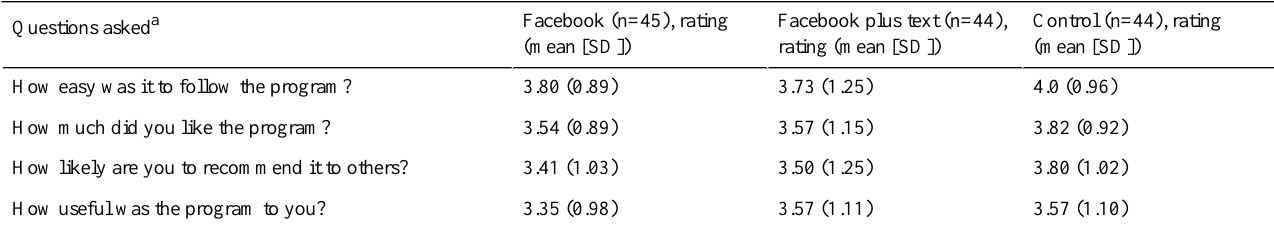
Table 7. Process evaluation of the CAlcium Nutrition-Dietary Opportunities study on intervention experience.